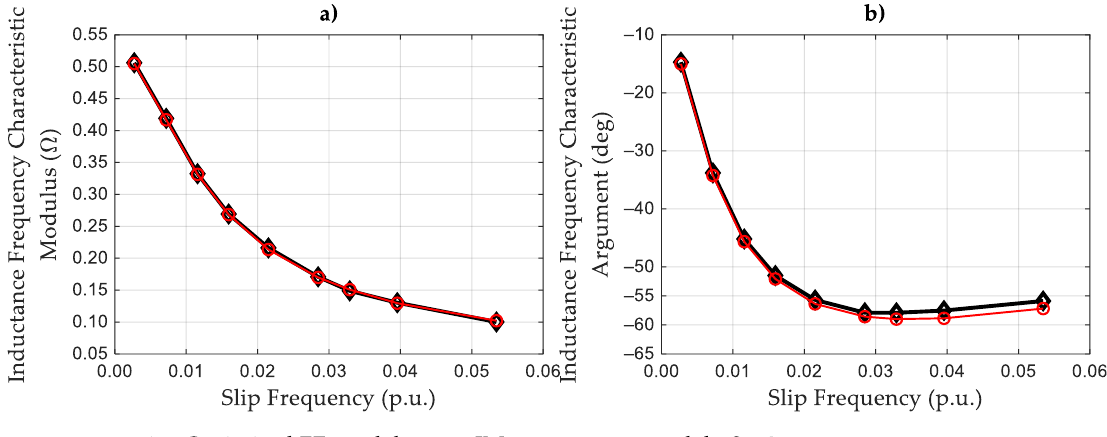
Figure 6. The inductance frequency characteristic determined based on the data derived from the simulation of the LCT and its approximation by means of the IM mathematical model: ( a ) modulus and ( b ) argument.